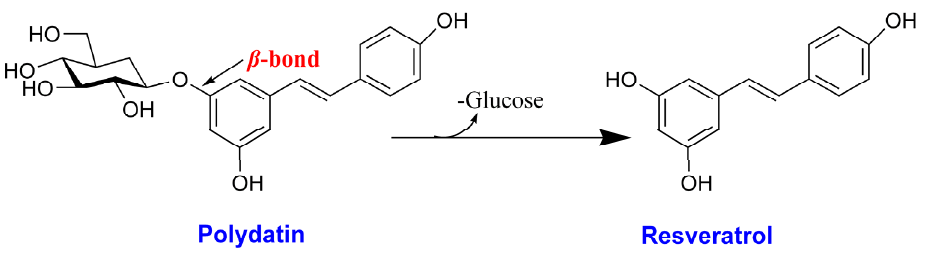
Figure 1. The structures of polydatin and resveratrol, and their biotransformation